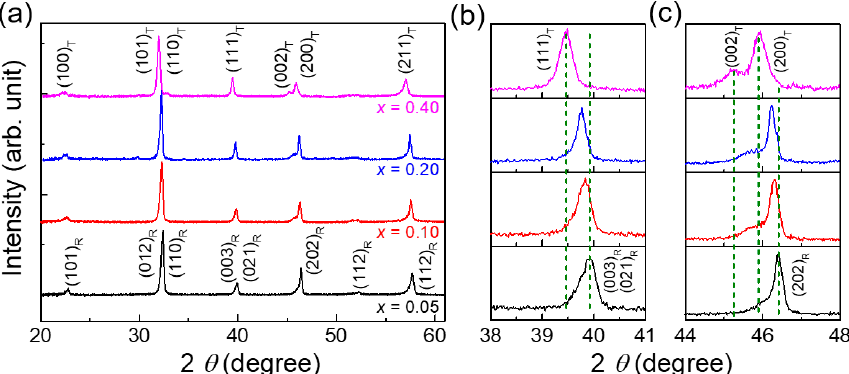
Figure 3. X-ray diffraction patterns of ( a ) BNKT ceramics, their magnification in ( b ) 2 θ range of 38° to 41°, ( c ) 2 θ range of 44° to 48°.